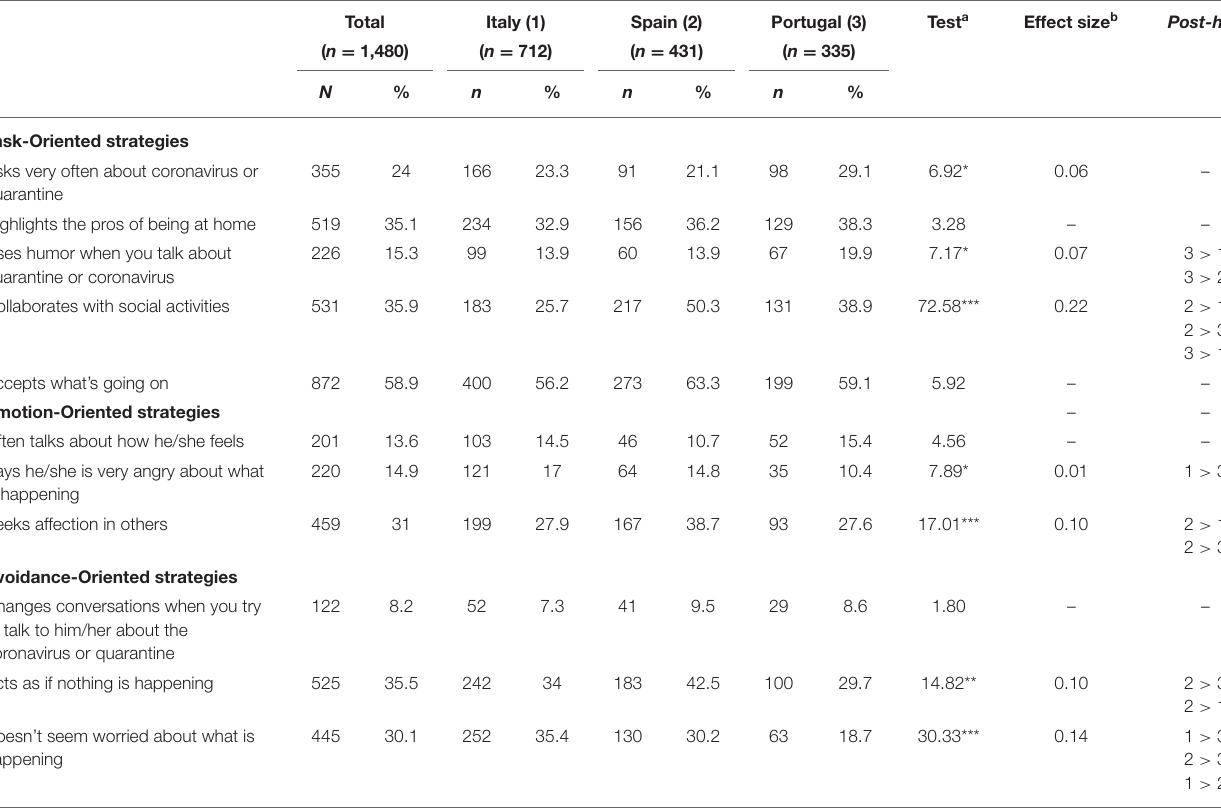
TABLE 2 | Coping strategies by country. Total Italy (1) Spain (2) Portugal (3) Test a Effect size b